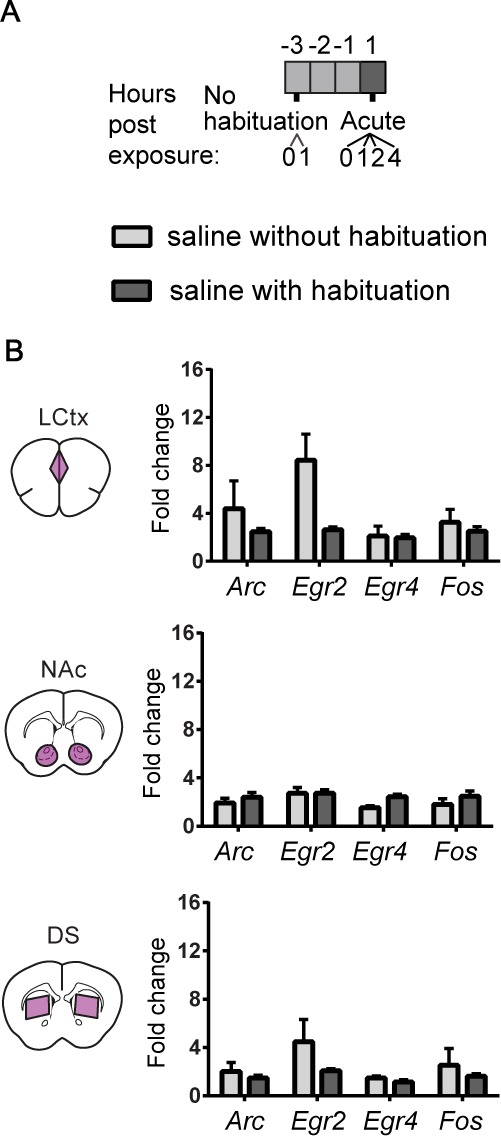
Characterization of repeated saline exposures illustrates the effect of habituation on induced transcription.(A) Experimental paradigm for i.p. saline injections. (B) Bar graphs demonstrating the transcriptional induction of Arc, Egr2, Egr4 and Fos in the LCtx, NAc, and DS (limbic cortex, nucleus accumbens, and dorsal striatum, respectively) 1 hr following i.p. injection of saline with no prior habituation (n = 4), or following three days of habituation (n = 5). Results show mean ± s.e.m.